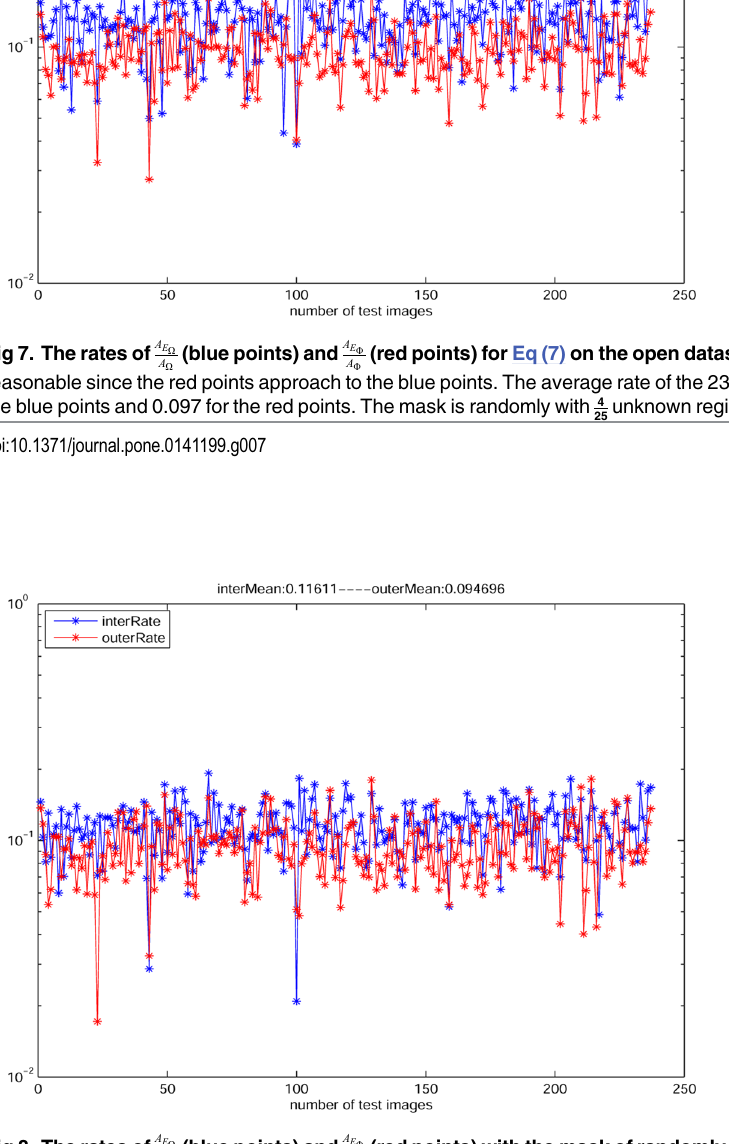
(blue points) and A E F A O